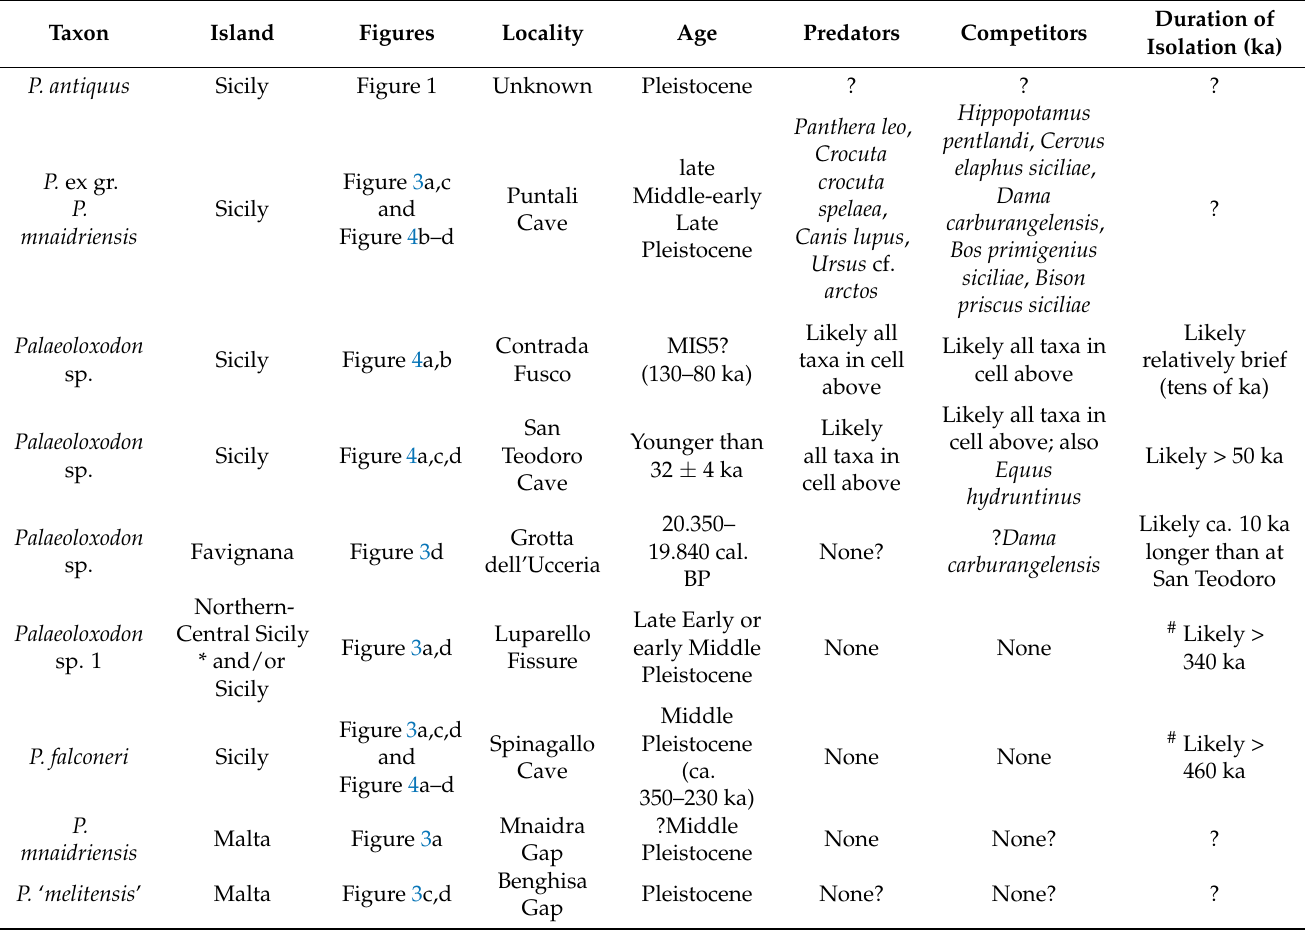
Table 2. Factors which likely influenced the evolution of reduced size in Pleistocene Siculo-Maltese Palaeoloxodon spp. For Faunal Complex associations and chronology refer to [8,9,67] and references therein [68]. * See palaeogeography in Figure 1. Note that some Palaeolxodon lineages/taxa were isolated on multiple Siculo-Maltese islands. # Assuming an arrival of 690 ka or earlier (p. 31 in [8] and references therein). The duration of isolation of P. ex gr. P. mnaidriensis from Puntali Cave is unknown, but see also